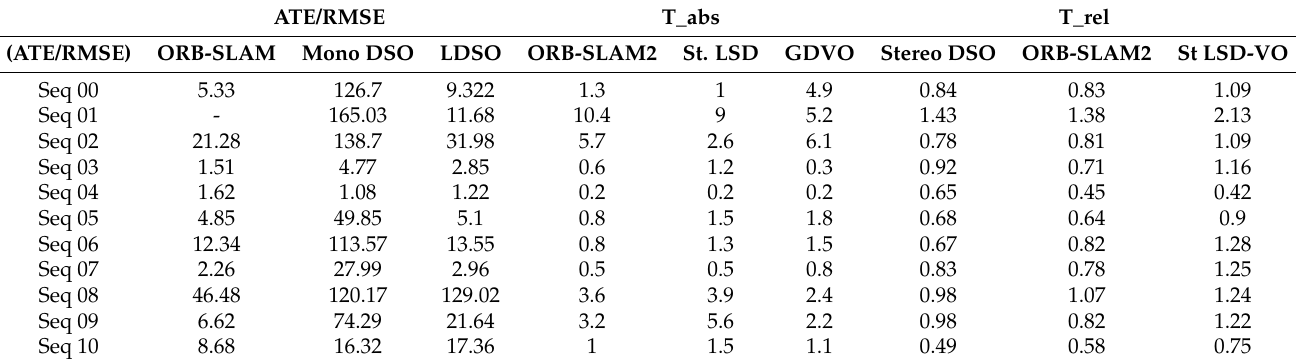
Table 1. Since ORB-SLAM2 is the most complete state-of-the-art VSLAM pipeline in feature- based methods (includes almost all the modules of VSLAM as proposed in the model), it achieves the best performances on this dataset. Stereo DSO [62] and Stereo LSD [61] can be observed in Table 1 to be a close seconds in terms of relative and absolute translational errors, respectively. Table 1. Absolute trajectory error (RMSE) on the KITTI Odometry Benchmark Dataset for state-of-the-art VSLAM implementations.